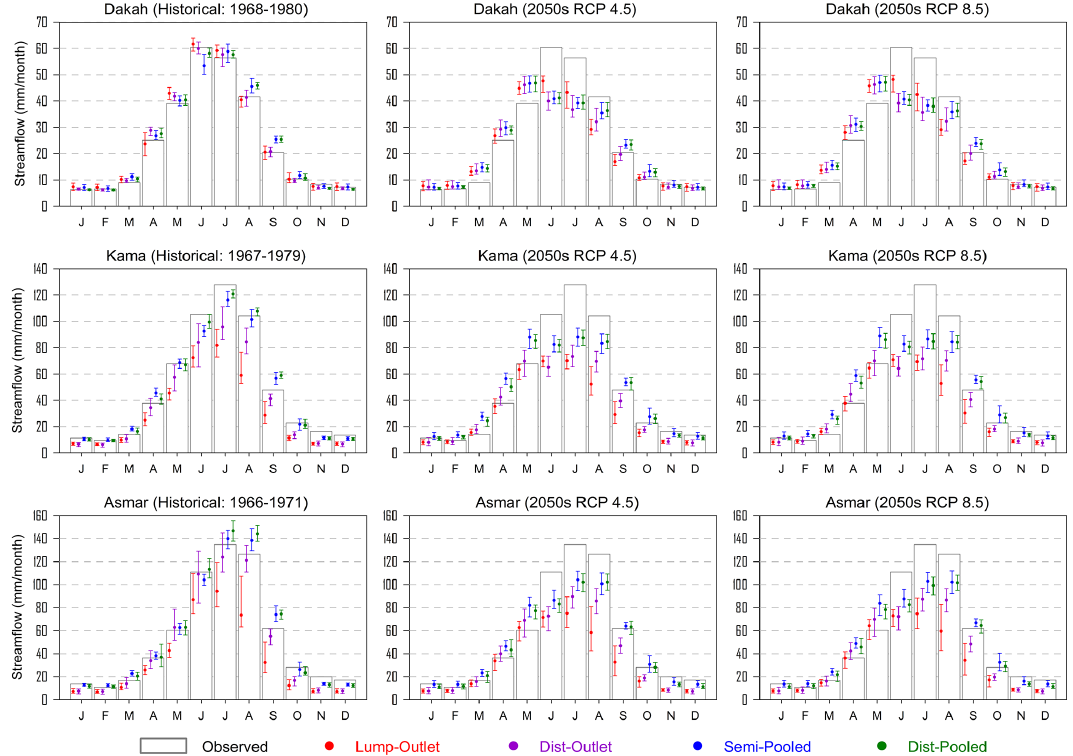
Figure 10. Historical and 2050s average monthly streamflow predictions at Dakah, Kama, and Asmar under four calibration strategies: Lump-Outlet, Dist-Outlet, Semi-Pooled, and Dist-Pooled. The error bars represent the streamflow ranges resulting from 50 trails of the HYMOD_DS calibration. For each of the 50 trials, the 2050s streamflow predictions are averaged over 36 GCM climate projections.